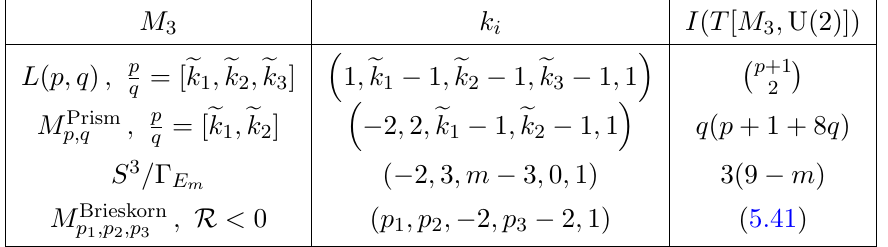
Table 3 . Three-manifold, quiver data and vacuum count in terms of the Witten index I for various Seifert manifolds M 3 with G =